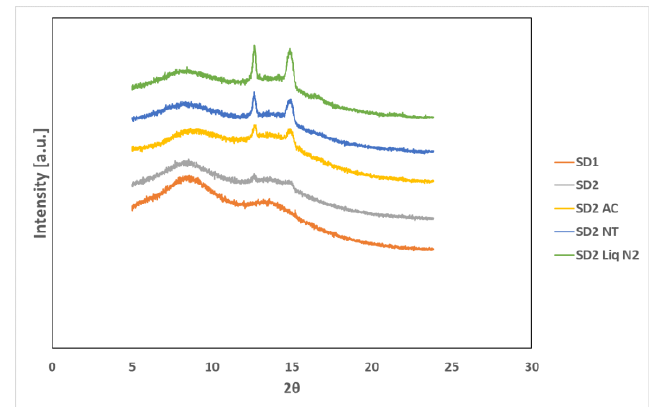
Figure 14. XRPD diffractograms of SD formulations and XRPD diffractograms of the SD formulation used to investigate the effect of cooling after 5 months of a stability study under accelerated conditions of 40 °C and 75% RH. P407 was still present in its crystalline form in all formulations (AC = Air cooled, NT = Normal room temperature and Liq N 2 = Liquid Nitrogen).